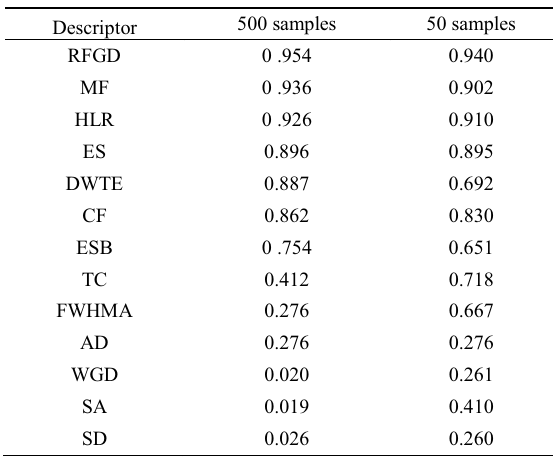
Table 2. Comparative graphs of the four evaluated features